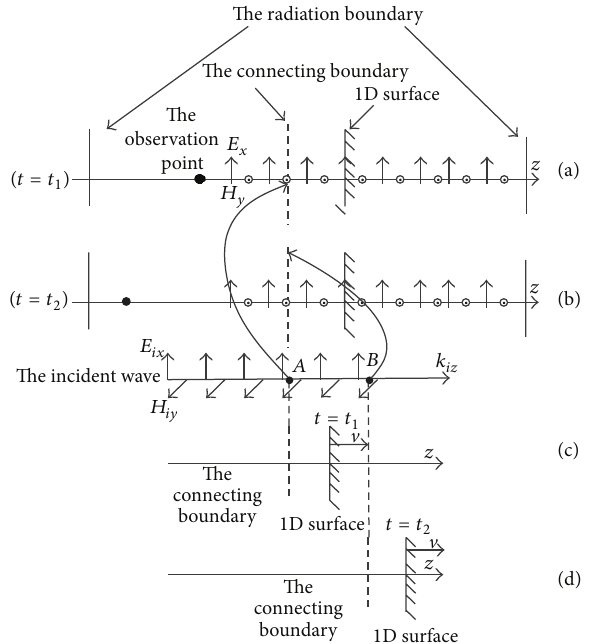
Figure 3: An improved FDTD model for the conducting surface being relatively static in the computational